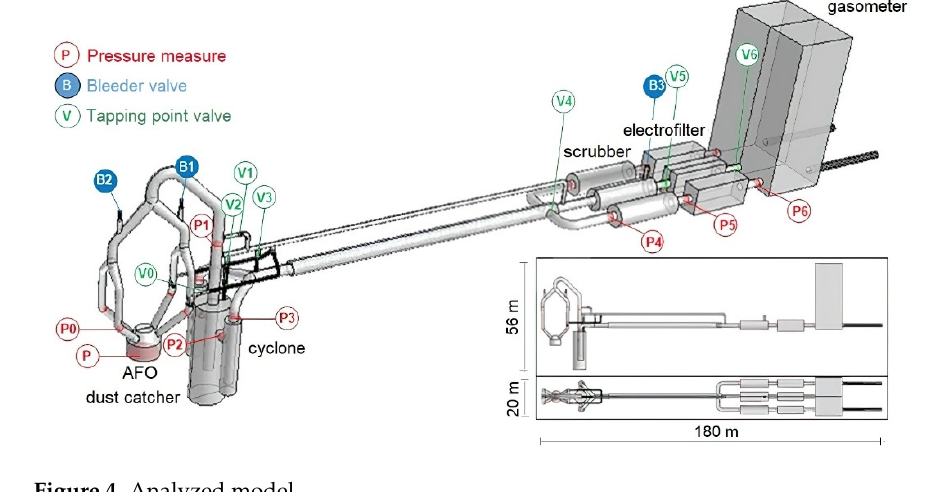
Figure 4. Analyzed model.